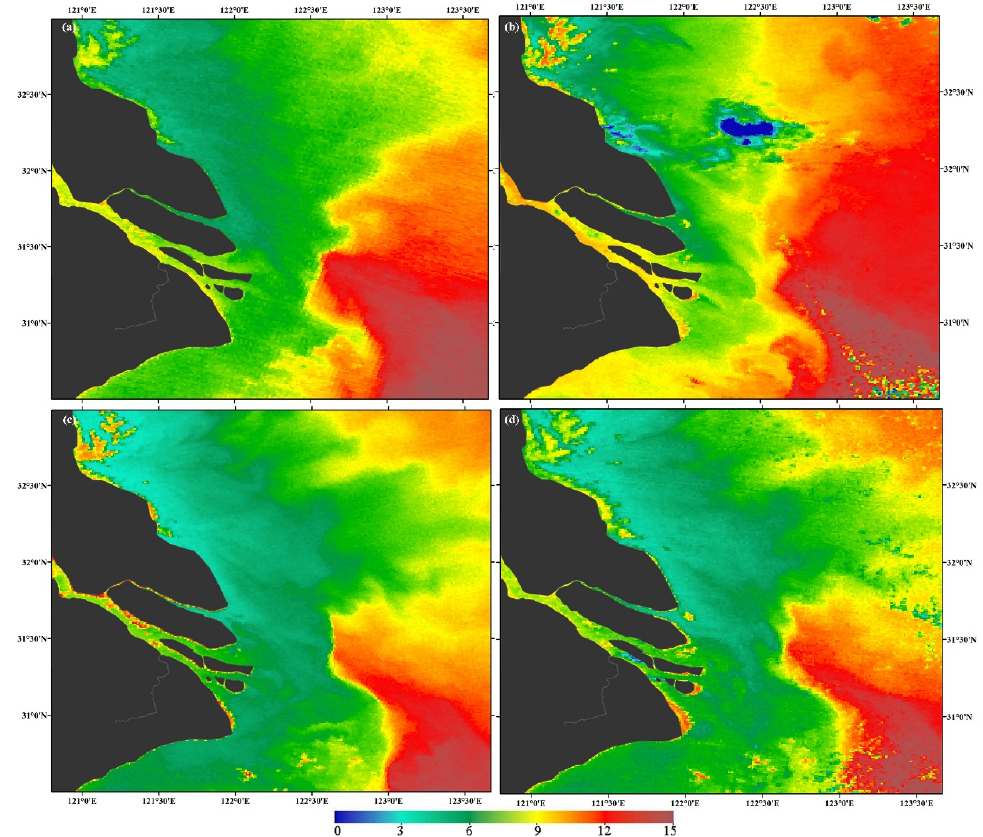
Figure 9. Characteristics of the temperature field in the Yangtze Estuary after the cold wave (where ( a – d ) are for 9 January 2015 (1 day after the cold wave), 30 December 2021 (2 days after the cold wave), and 18 January (1 day after the cold wave) and 19 January, 2021 (2 days after the cold wave), respectively).